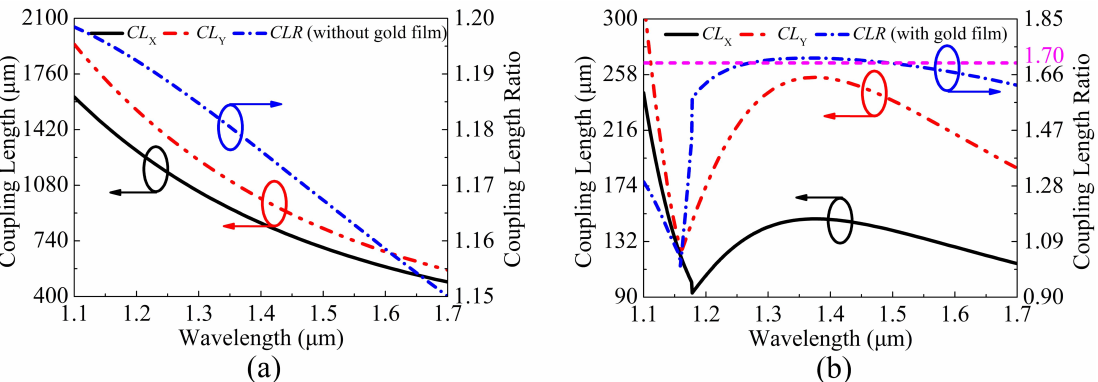
Figure 4. The CL X , CL Y , and CLR as functions of the wavelength when the V-DC-PCF is coated ( a ) without gold film and ( b ) with gold